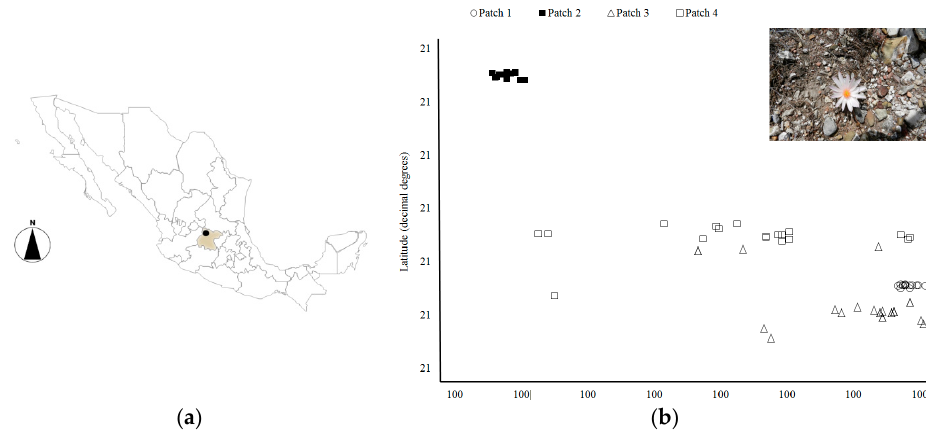
Figure 1. Location of the study area in the Mexican Republic. In ( a ) the shaded area indicates the Guanajuato state and the dark point the approximate location of the arid hills occupied by Mammillaria albiflora ; in ( b ) the real geographic distribution of the sampled individuals and the patch in which they were collected is marked with a symbol. The precise geographic coordinates are omitted in the axes due to the critical conservation concern of the species (photo by Sofia Solórzano).